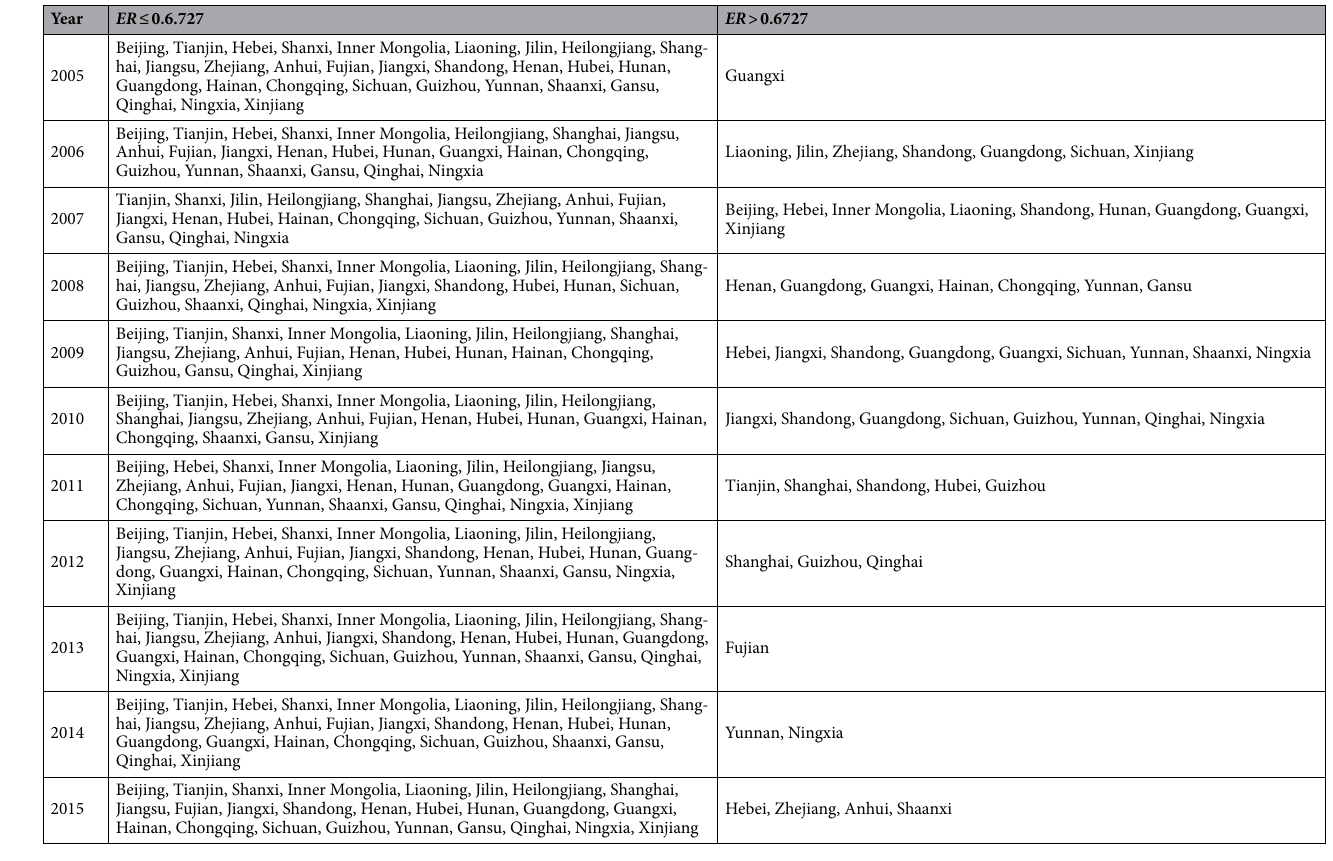
Table 7. The distribution of provinces and cities under different threshold intervals over the